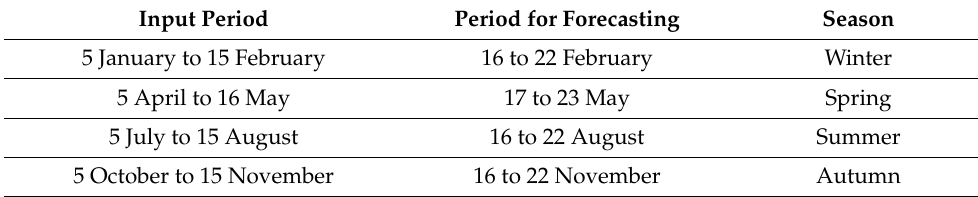
Table 2. The studied period in 2018 for the electricity market of the US. Input Period Period for Forecasting